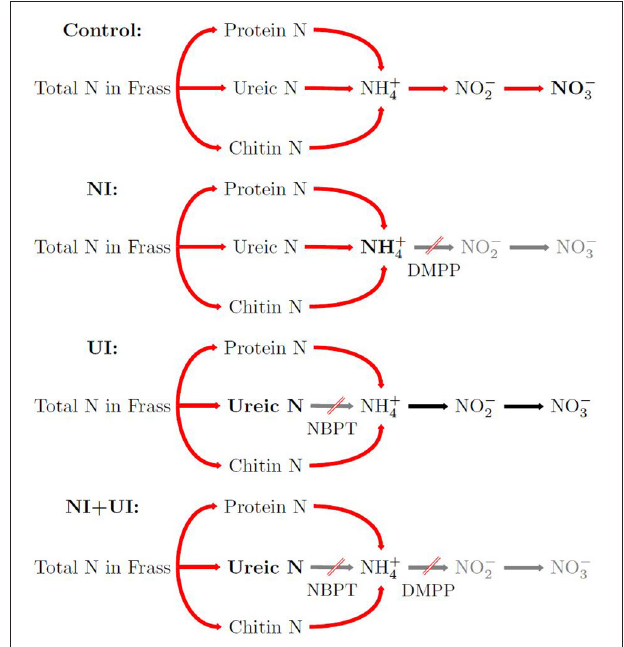
FIGURE 1 | Simplified visualization of nitrogen mineralization processes targeted in the different experimental treatments: control shows normal N release, nitrification inhibitor (NI) slows ammonium oxidation, urease inhibitor (UI) slows N release from ureic organic N, combined inhibitor application (NI + UI) slows N release from ureic organic N, and ammonium oxidation as well. DMPP, 3,4-dimethylpyrazole phosphate (NI); NBPT, N-(n-butyl) thiophosphoric triamide